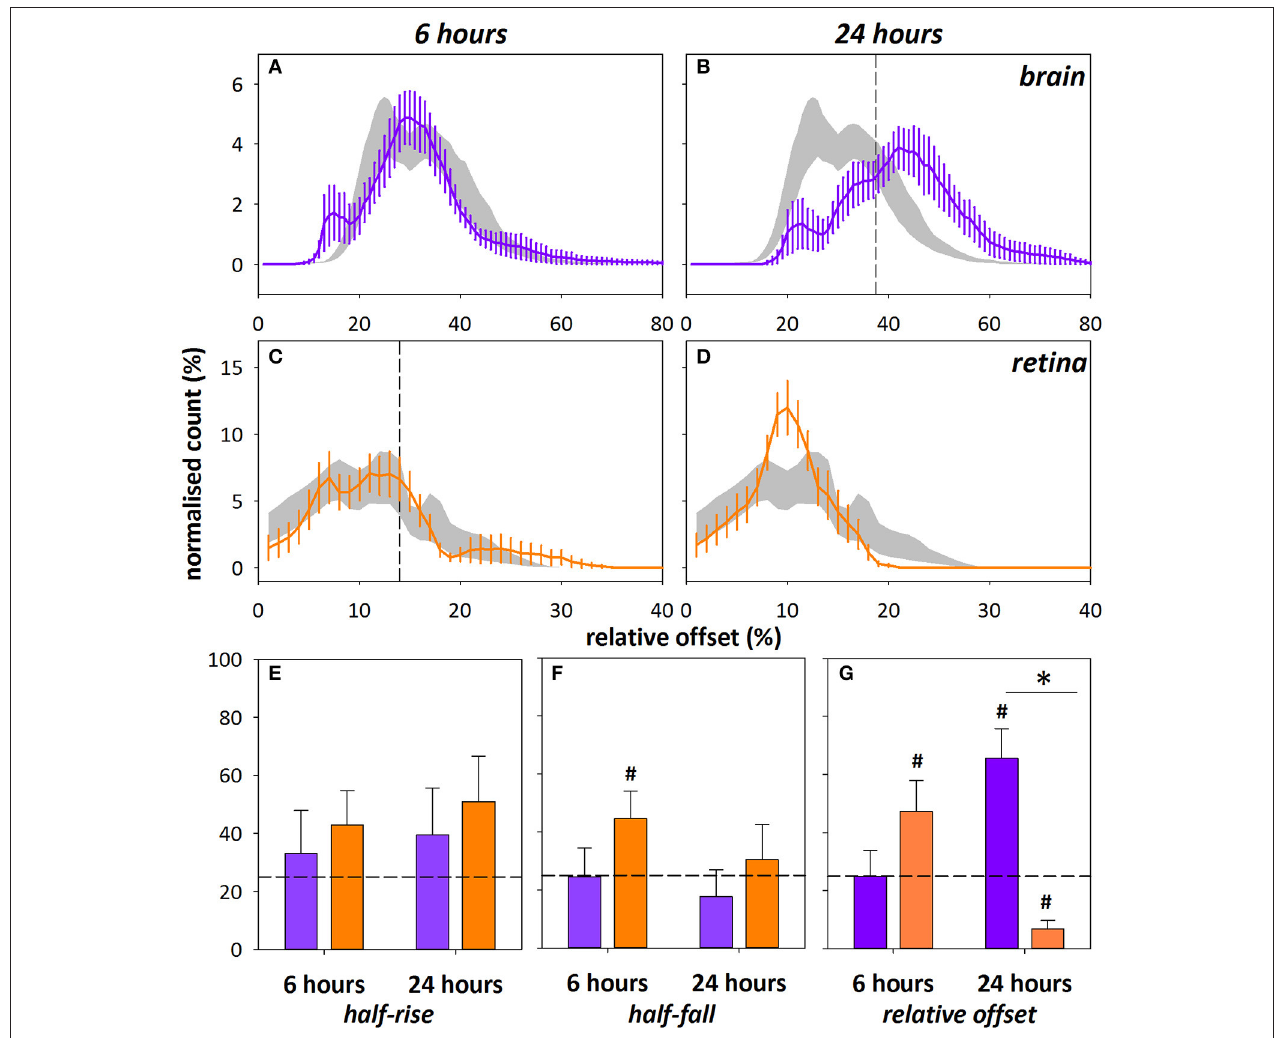
FIGURE 5 | Frequency histograms for relative offset at 6 and 24h after DOC administration in cortical ( A,B , purple) and retinal ( C,D , orange) capillaries/extravascular space. Saline control ± SEM shown in gray, vertical dashed line indicates 75% cut-off determined from the saline control group. Note the different scales for offset between brain and retina. The index of injury (number of pixels above 75% cut-off, %) for the half-rise (E) , half-fall (F) , and relative offset (G) at 6 and 24h after DOC injury. Data shown for capillaries only, arteries and veins were similarly altered (Figure S3). *Indicates significant difference between groups at 24h time point, p < 0.001, Mann–Whitney test. # Denotes indices > ± 2 SEM from 25% (horizontal dashed